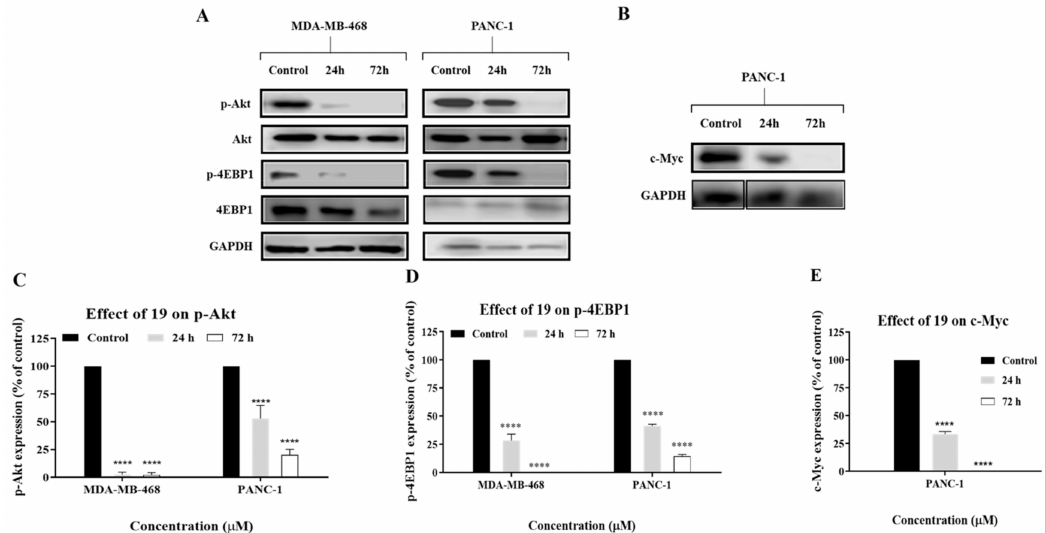
Figure 12. ( A , B ) Western blot analysis of p-Akt, Akt, p-4EBP1, 4EBP1, and c-Myc. MDA-MB-468 and PANC-1 cells were treated with 19 for 24 h and 72 h at a concentration of 2 × GI 50 . GAPDH was used as an internal control. ( C – E ) Collated densitometric measurement of protein expression levels in MDA-MB-468 and PANC-1 cells. The experiment was repeated at least three times. Bars and error bars refer to the mean ± SD. **** p < 0.0001 vs.